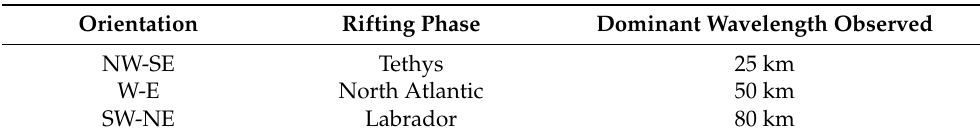
Table 1. Dominant Boudinage Wavelengths Observed in 2D Seismic Data Corresponding to Each Rift Phase in the Upper